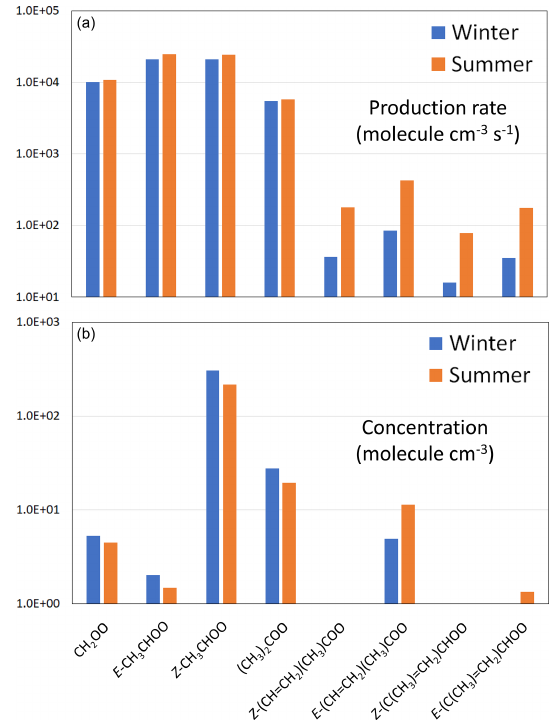
Figure 4. Production rates (a) and steady-state concentrations (b) for the core set of C 1 –C 4 sCIs for representative rural background conditions in the south-eastern UK. Note that the information is presented on log scales, with cut-offs of 10molec.cm − 3 s − 1 and 1molec.cm − 3 , respectively. The total sCI production rates and con- centrations are given in Table 8. Results for an extended series of 28 sCIs, and for suburban and urban traffic conditions, are presented in Supplement